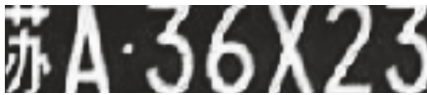
Figure 7: Accurately poisoning image of the license